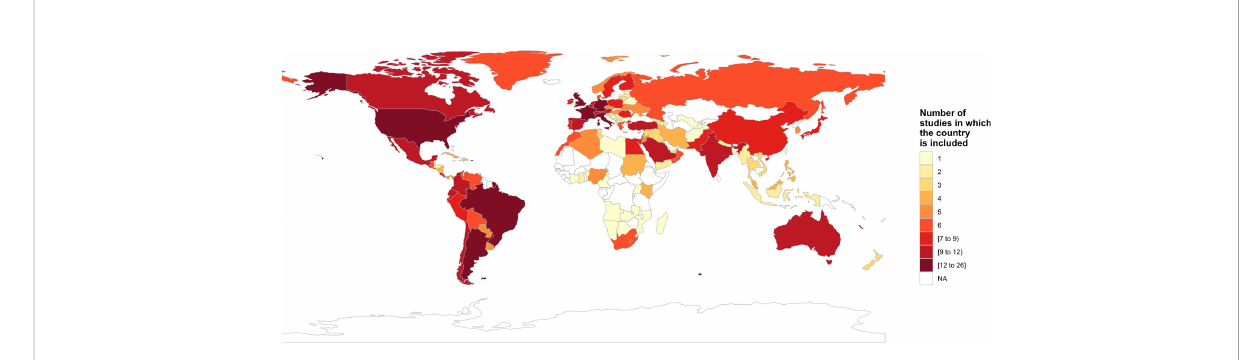
FIGURE 2 Worldwide distribution of the included